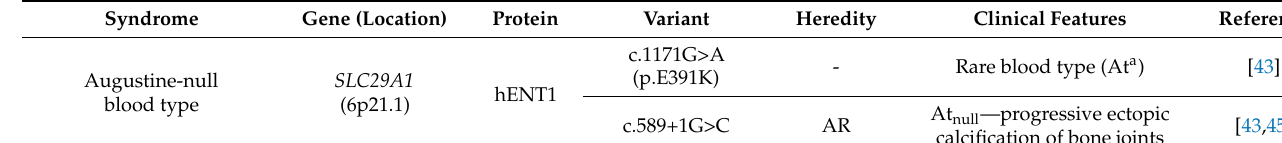
Table 1. Nucleoside transporter genetic variants and associated